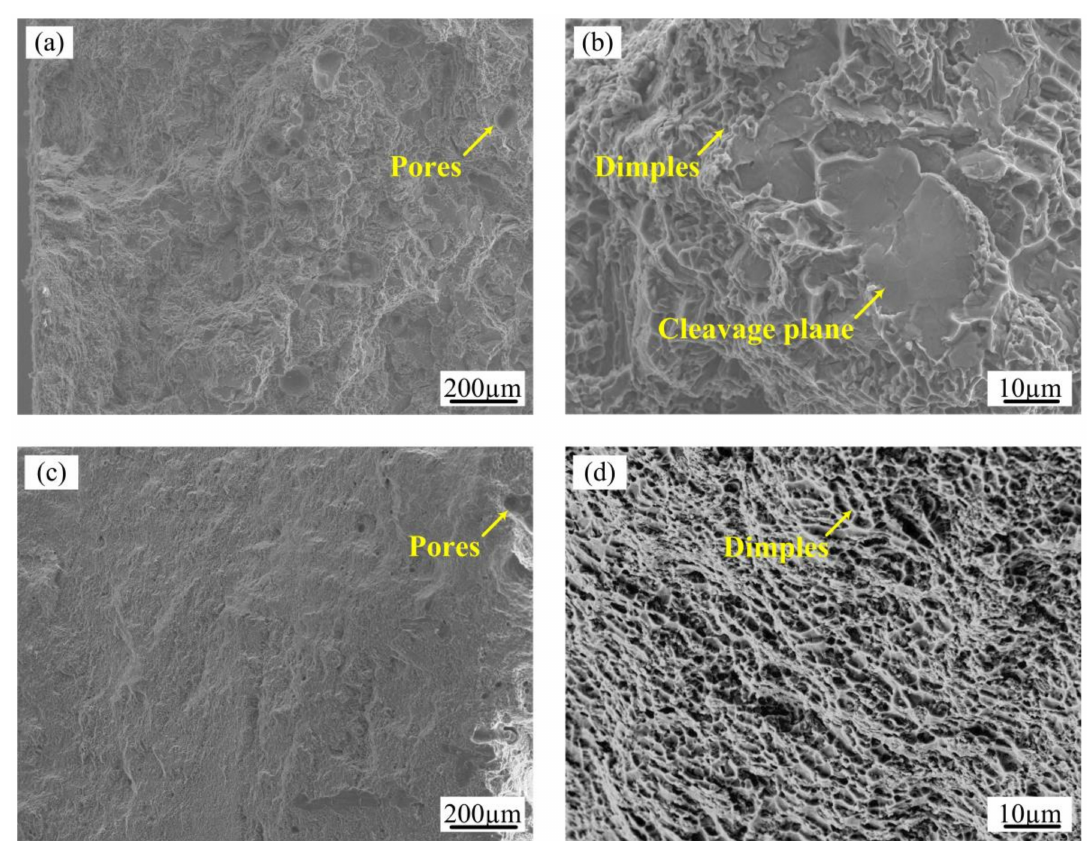
SEM photographs of the fracture surface of the tensile test: ( a , b ) overview and magnified images of the casting material; and ( c , d ) overview and magnified images of the UALMD-processed